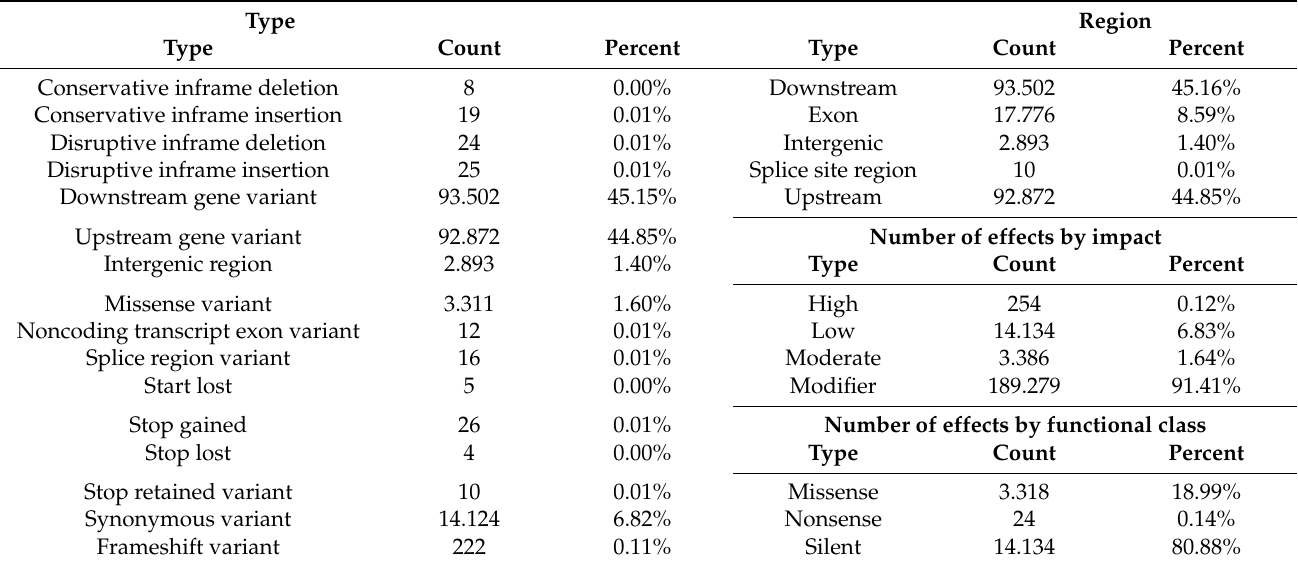
Table 1. Summary of detected variants between S. putrefaciens CN-32 and Shewanella sp.